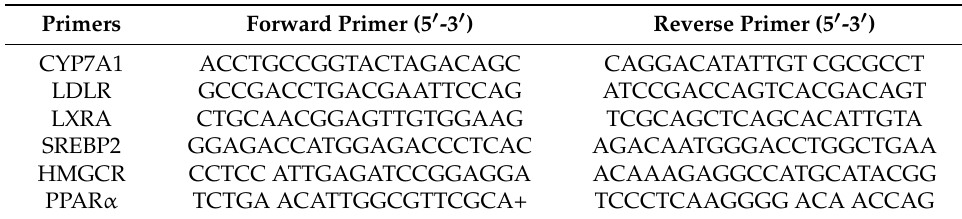
Table 2. Primer pairs were used for